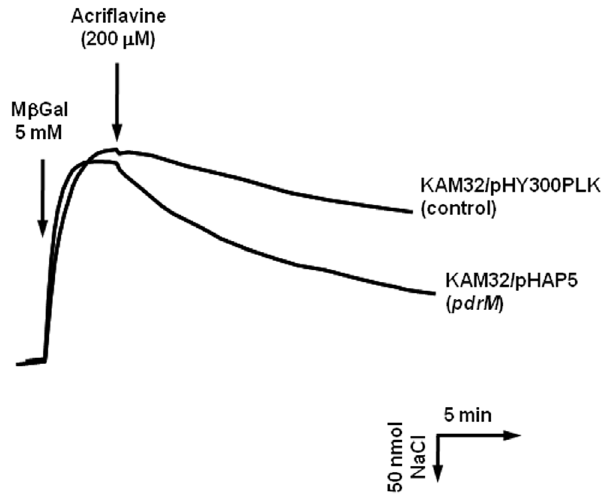
Figure 3. Na + efflux from Na + -loaded cells elicited by an inwardly directed acriflavine gradient. Cells of E. coli KAM32/ pHAP5 or E. coli KAM32/pHY300PLK (control) were diluted with 0.1 M MOPS-TMAH (pH7.0) until approximately 9 mg protein/ml. Na + was loaded to cells via MelB by the addition of M b gal (the first arrow), and acriflavine (final 200 m M) was added to the assay mixture at the time point indicated by the second arrow. Upward deflection of the curve indicates Na + influx into cells and downward deflection indicates Na + efflux from cells.